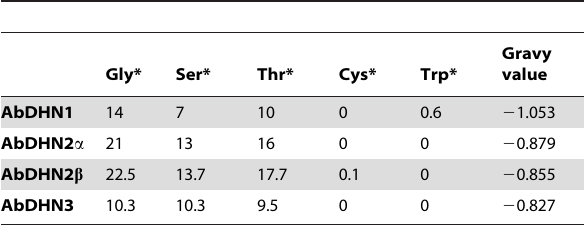
Table 1. Characteristics of the dehydrin-like proteins found in A.